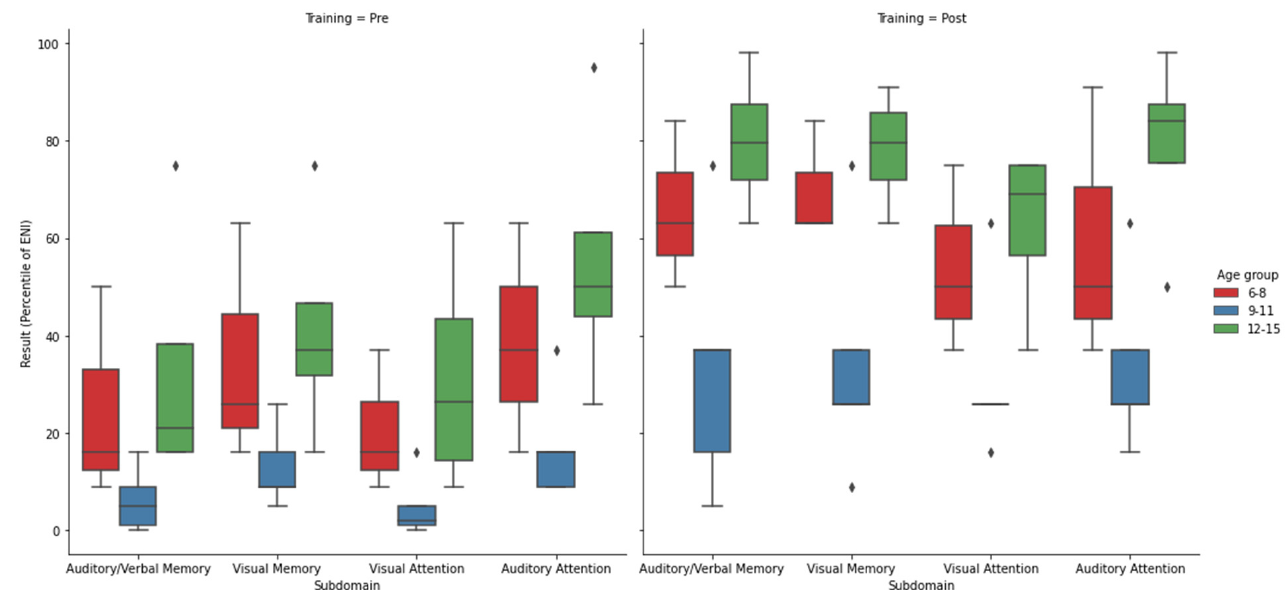
Figure 7. Differences between age groups for results of phase I and phase III.